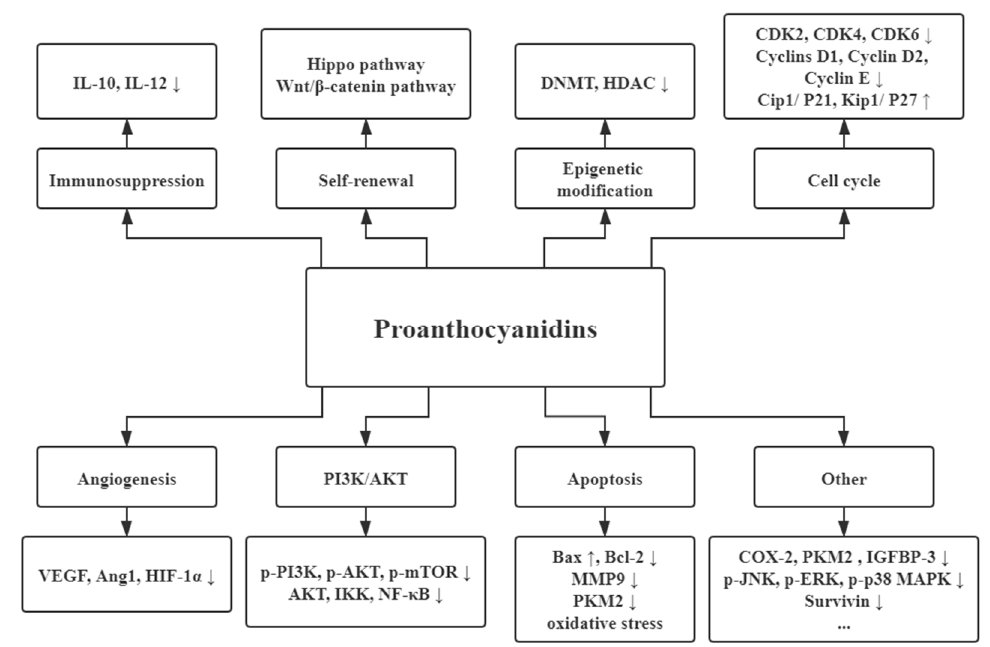
Figure 1. The dominating mechanisms of proanthocyanidins in cancer prevention or therapy. IL-10, interleukin-10; IL-12, interleukin-12; DNMT, DNA methyltransferase; HDAC, histone deacetylase; CDK2, cyclin dependent kinase 2; CDK4, cyclin dependent kinase 4; CDK6, cyclin dependent kinase 6; VEGF, vascular endothelial growth factor; Ang1, angiopoietin 1; HIF-1 α , hypoxia inducible factor 1 subunit alpha; Bax, BCL2 associated X, apoptosis regulator; Bcl-2, BCL2 apoptosis regulator; MAPK, mitogen-activated protein kinase; MMP9, matrix metalloproteinase; PI3K, phosphoinositide-3-kinase; AKT, protein kinase B; p-mTOR, phosphorylated mechanistic target of rapamycin kinase; IKK, inhibitor of nuclear factor κ B kinase; NF- κ B, nuclear factor κ B subunit 1; COX-2, cyclooxygenase-2; PKM2, pyruvate kinase M2; IGFBP-3, insulin like growth factor binding protein-3; JNK, Jun amino-terminal kinase; ERK, extracellular regulated protein kinase.